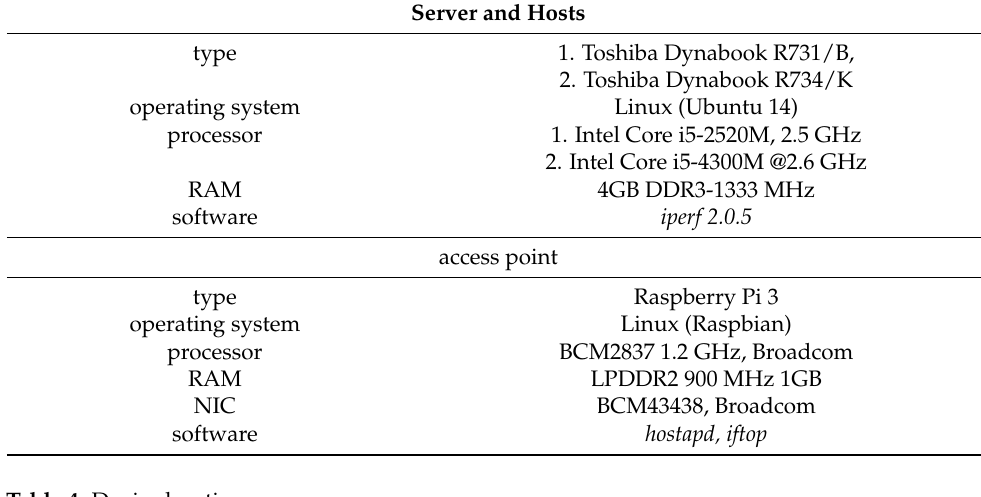
Table 3. Hardware and software specifications.